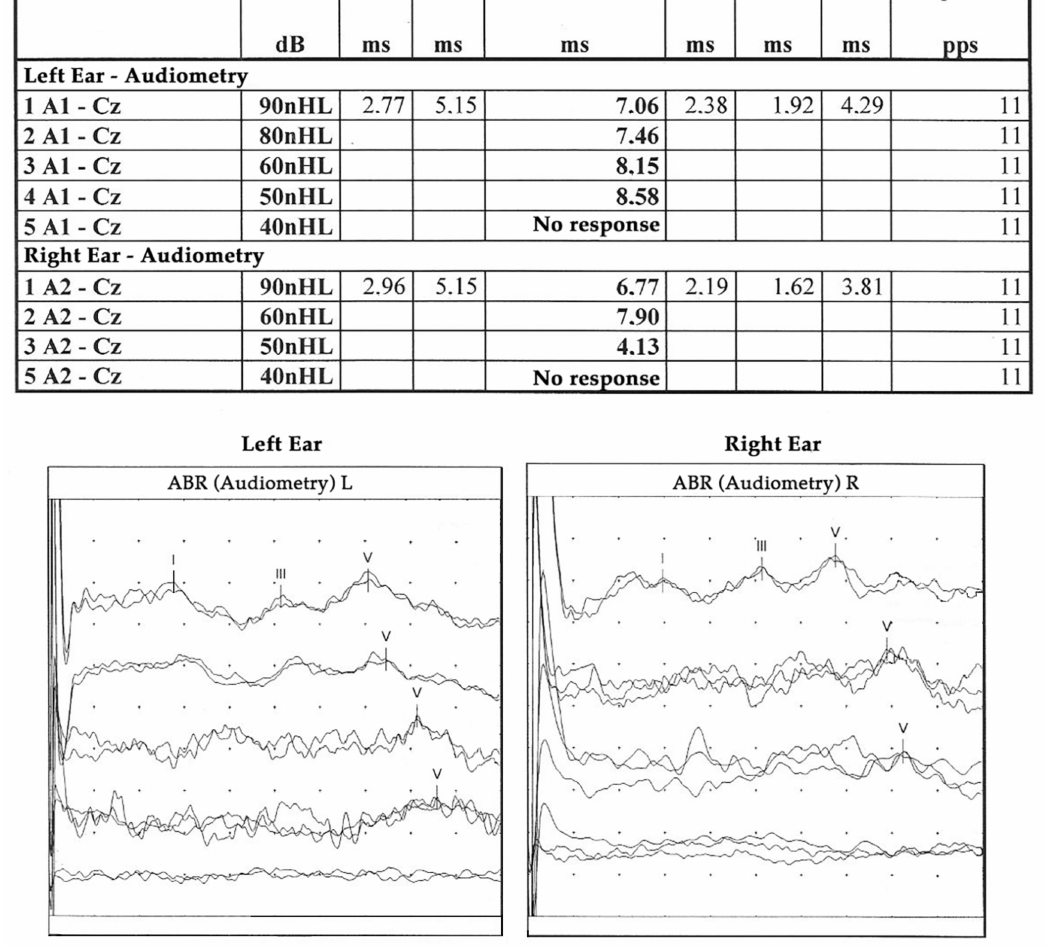
Figure 1. Auditory brainstem responses at 2 months of age, per monaural click with contralateral masking of +30 dB. Note that wave I falls outside the normal latency levels, but there is a normal wave V latency at higher intensities. Auditory thresholds at 50 dB, with no response to lower values. Intervals within normality, without retrocochlear signs. Stim.: Stimulation; Rep. Rate: repetition rate; ms: milliseconds; Cz: reference electrode in the vertex; A1: registration electrode; A2: the registration electrode in the right ear; HL: normalized hearing level; ABR: Auditory brainstem